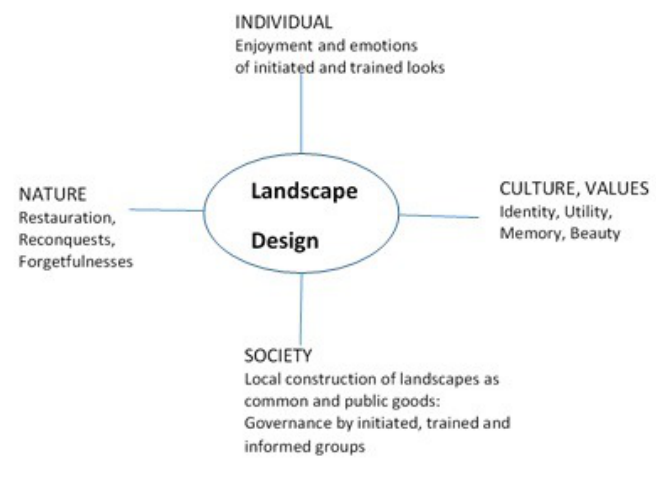
Figure 15: The four pole model for landscape